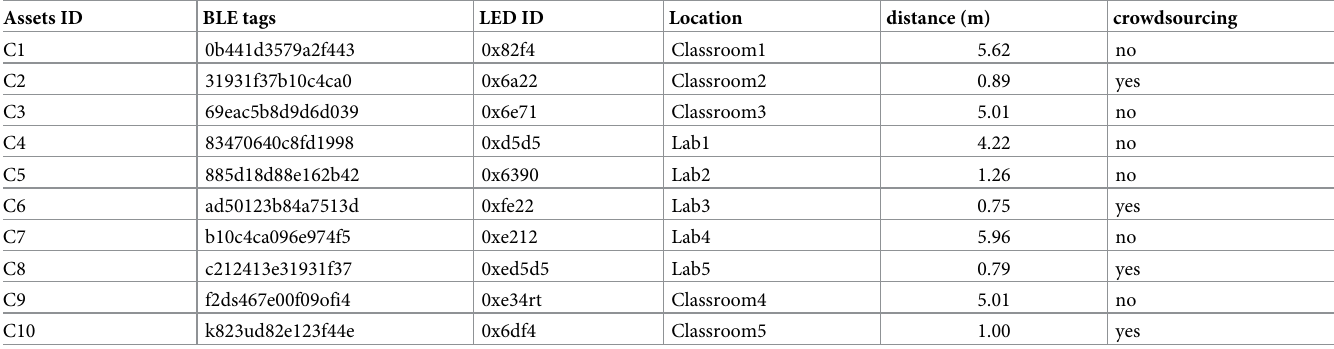
Table 3. Crowdsourcing